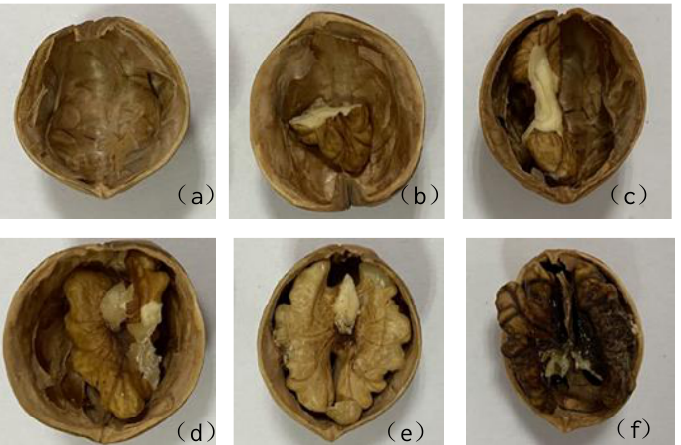
Figure 1. Internal images of walnut samples. ( a ) Empty shell; ( b ) 1/4 Walnut kernel; ( c ) 1/2 Walnut kernel; ( d ) 3/4 Walnut kernel; ( e ) Plump walnuts; ( f ) Mildewed kernel